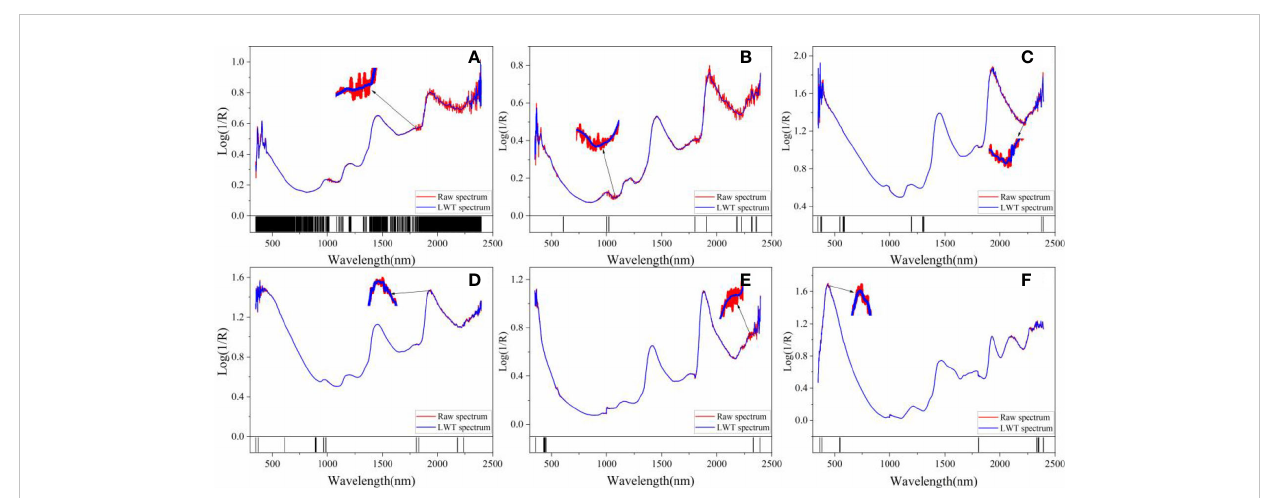
FIGURE 8 The distributions of selected variables by the optimal method for each tree species. (A – F) are Tilia tuan Szyszyl., Acer mono Maxim, Chinese white poplar (Jilin), Japanese elm, Chinese white poplar (Heilongjiang), and Dahurian larch,